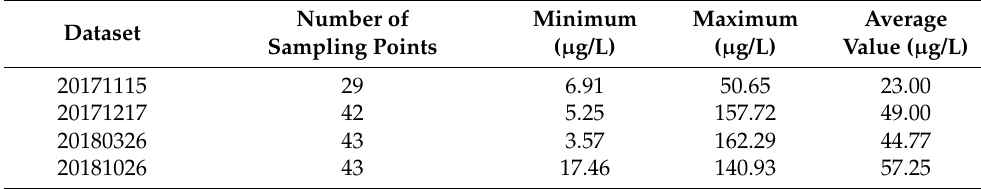
Table 1. The comparation of chlorophyll a concentration in four datasets.